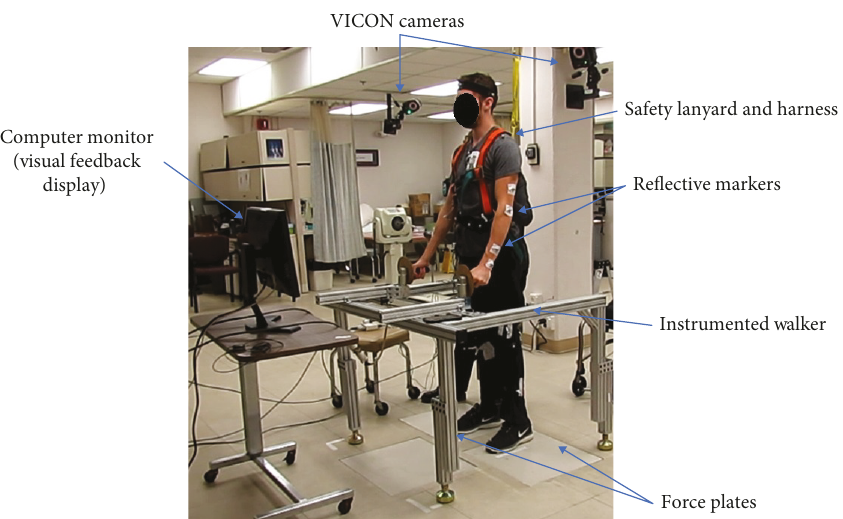
Figure 3: Set-up for experimental evaluation of the controller. The subject stands erect on force plates, while holding onto an instrumented walker and adjusting the overall center of pressure (CoP) position towards the end of paths in the forward and diagonal directions. The subject was provided with visual feedback while adjusting the overall CoP position. Re fl ective markers were mounted on the subject to track his joint positions as he adjusted posture.